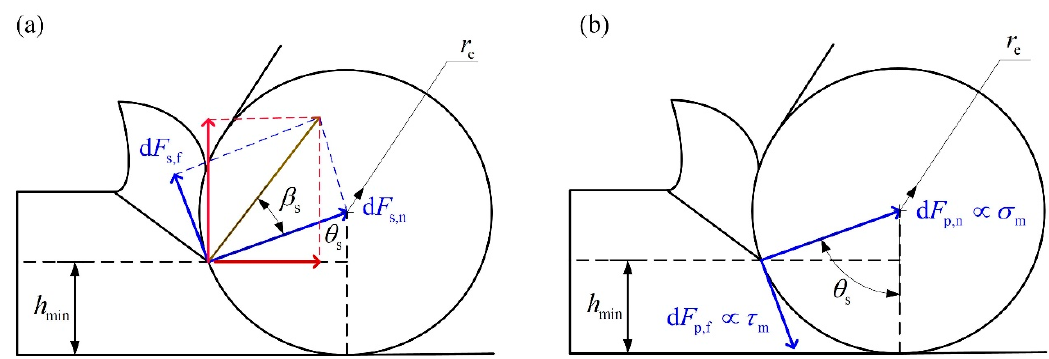
Figure 2. The distribution of the shear/ploughing force under the minimum uncut chip thickness. ( a ) The shear force above the minimum uncut chip thickness (MUCT) point; ( b ) the ploughing force under the MUCT point.